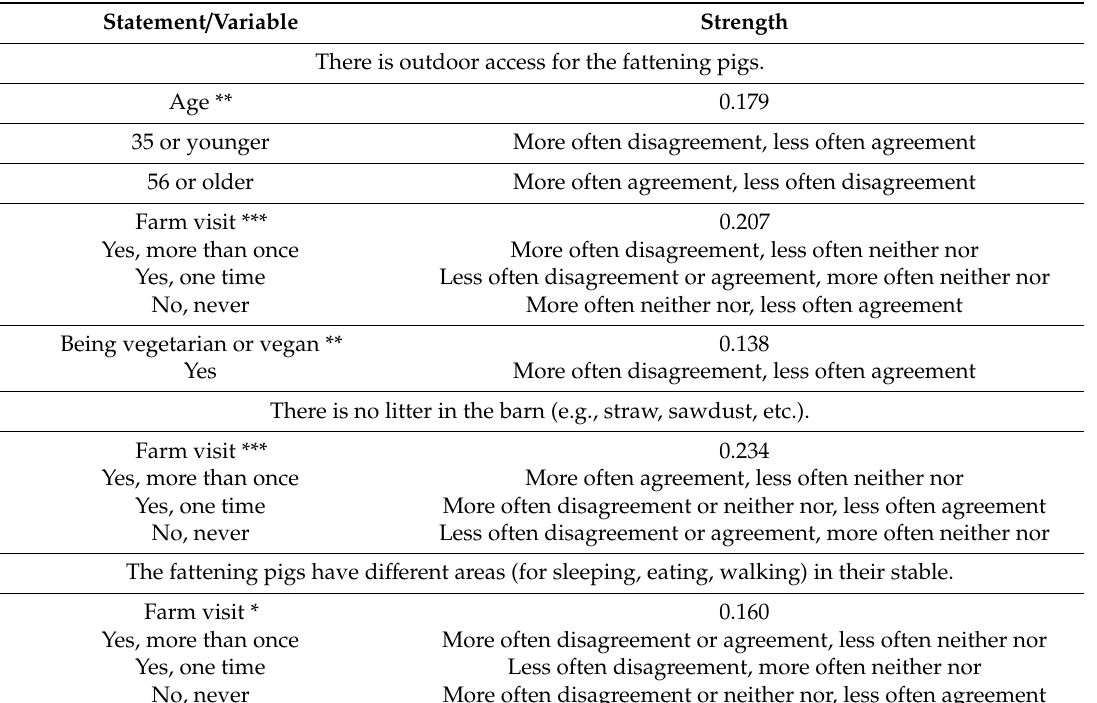
Table 2. Analysis for